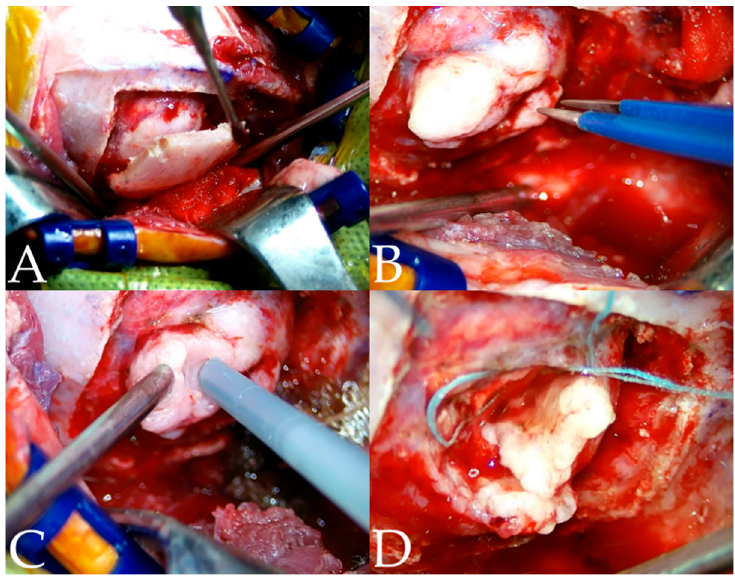
Figure 5. ( A ) Opening of the cranium. ( B ) The meningioma was identified, and bipolar was used to mitigate adjacent vessels during the resection. ( C ) The mass was removed using the ultrasonic aspirator in order to reduce the size of the mass. ( D ) The tumor was isolated from the brain parenchyma using neurosurgical sponges.